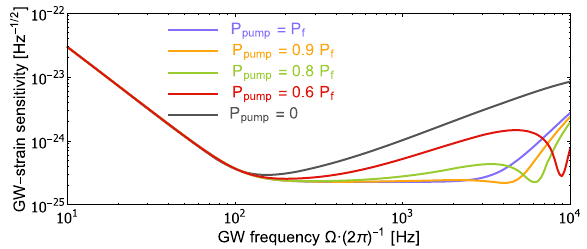
Fig. 3 Demonstration of tunable quantum noise spectrum in white light signal recycling interferometer. Adjustment of the quantum noise curve is achieved by changing the fi lter cavity pump power P pump relative to P f , which is the power required to achieve negative dispersion as per Eq. (3). This is useful for tuning the location of peak sensitivity in the neutron star detection band without changing interferometer hardware or detuning the signal